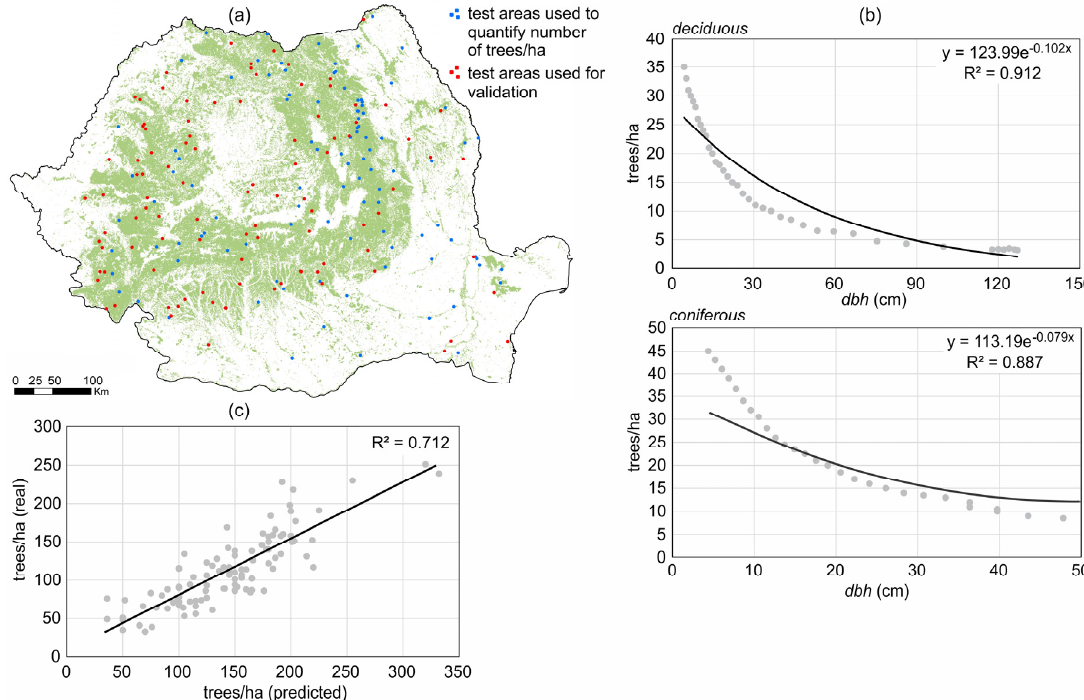
Figure 4. The generated test areas for the quantification of the real number of trees/ha used to predict the number of trees within the cells with unknown values and to assess their accuracy ( a ), the relationships between the estimated dbh and the number of trees/ha quantified on the ground ( b ) and the correlation between the real number of trees/ha quantified on the ground and the predicted by using dbh values ( c ).